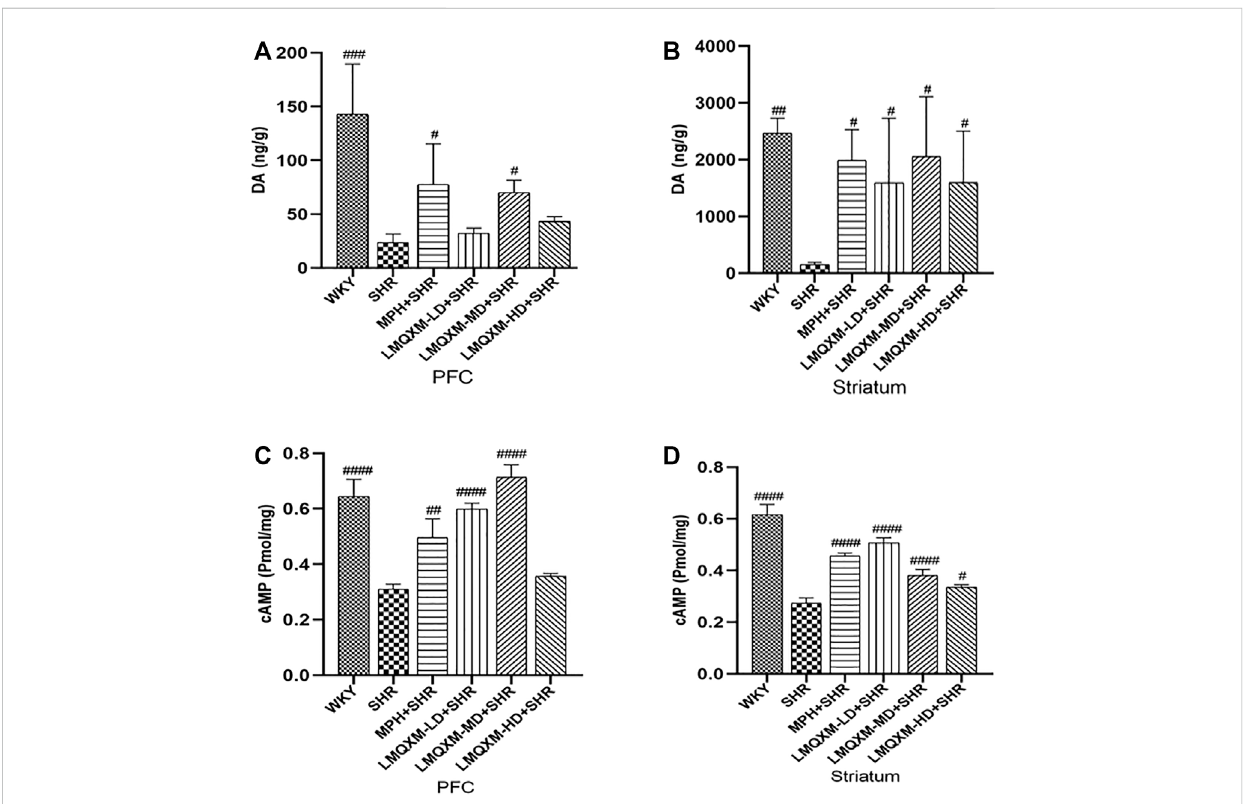
FIGURE 7 DAandcAMPlevelsinPFCandstriatumforeachgroupofrats (A) .DAlevelsinPFC (B) .DAlevelsinPstriatum (C) .cAMPlevelsinPFC (D) .cAMPlevels striatum. All data are presented as mean ± SD, n = 3 for each group. # p < 0.05, ## p < 0.01, ### p < 0.001 vs